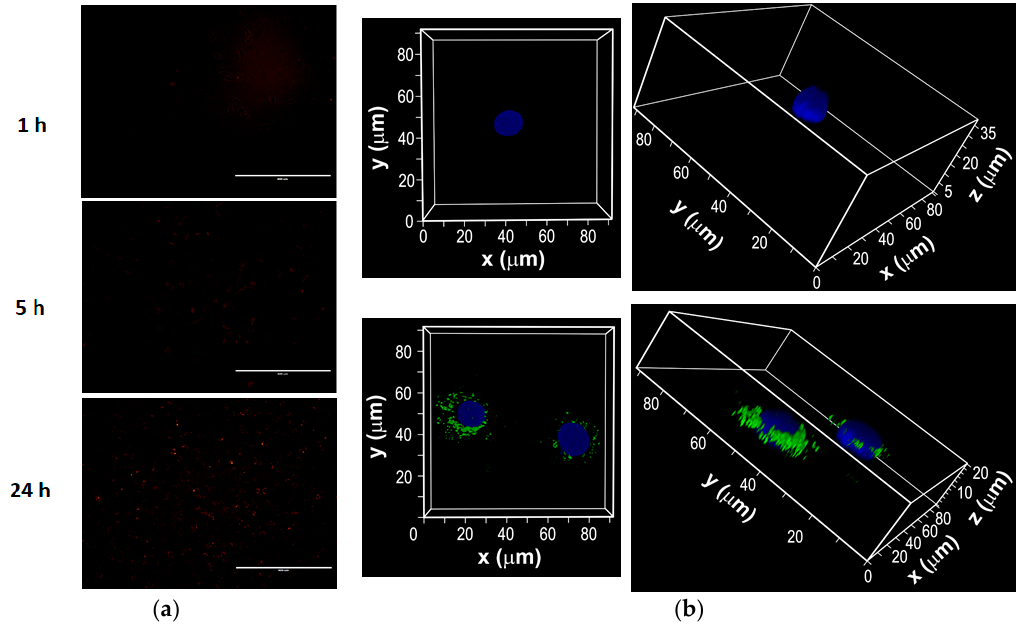
Figure 4. Intracellular uptake of DiI-labeled F18 by mouse epidermal JB6 P+ cells. ( a ) Epifluorescence images of cells incubated with DiI-labeled F18 for 1, 5, and 24 h. ( b ) Images were also taken with a laser scanning confocal microscope after the cells were incubated with F18 (labeled with DiI) for 3 h. Confocal Z-stacks of cells incubated with DiI-labeled F18 (green) for 3 h and Hoechst 33342 (blue). Upper panels: the control lacked drug treatment; lower panels: cells treated with F18. Magnifications are 63× by oil immersion. Overlay represents merged images from all channels.